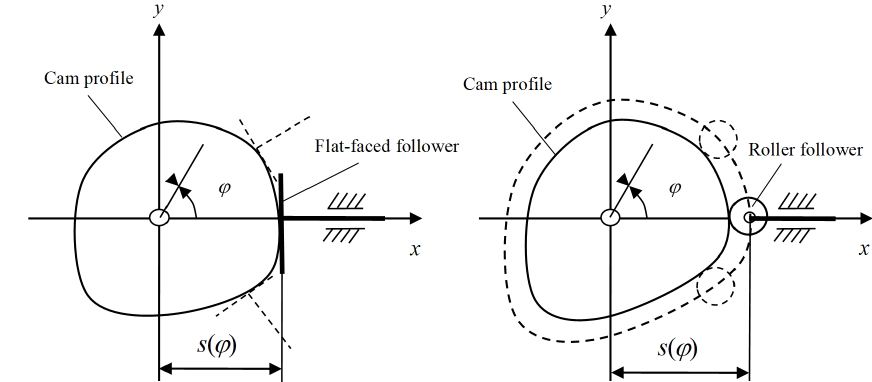
Figure 14. Cam systems with profiles with flat-faced and roller followers,